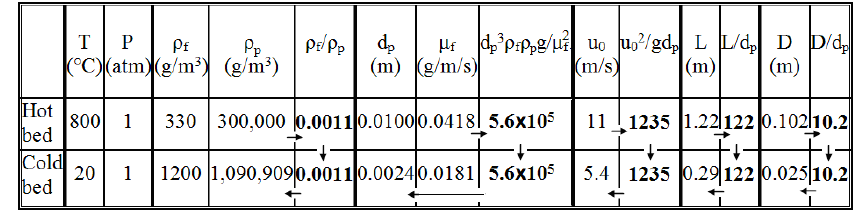
Figure 1. Estimation of the small column (cold bed) dimensions, particle properties, and gas specifications in the small column based on the large column (hot bed).